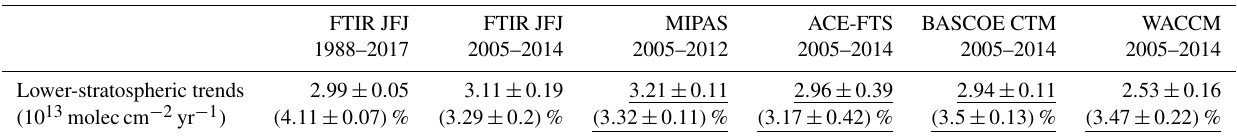
Table 4. HCFC-22 lower-stratospheric trends over JFJ. The uncertainties are given for the 2 σ level following the Santer et al. (2000) approach. Relative trends (%yr − 1 ) are given with respect to the yearly mean of the middle year of the considered period. Trends are underlined when not significantly different from the FTIR